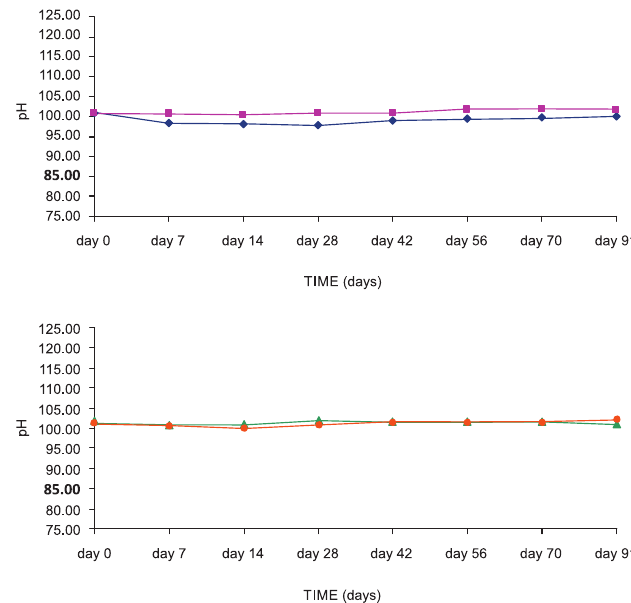
FIGURE 4 - Sildenafil citrate content (%) variation on aqueous solutions (mean ± standard deviation; n = 3).  preservative-free solution stored at 5 ºC ± 3 ºC and  stored at 25 ºC ± 2 ºC/60% RH ± 5% RH  solution containing preservative stored at 5 ºC ± 3 ºC and  stored at 25 ºC ± 2 ºC/60% RH ± 5% RH.